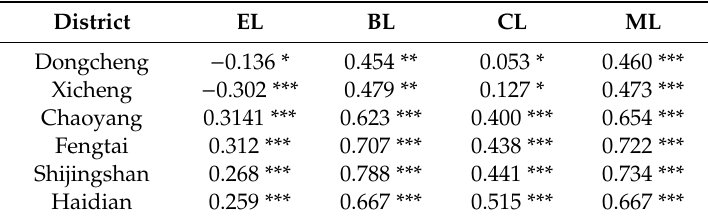
Table 5. The correlation coe ffi cients between the supply index (SI) and societal needs index (SNI). District EL BL CL ML Dongcheng − 0.136 * 0.454 ** 0.053 * 0.460 *** Xicheng − 0.302 *** 0.479 ** 0.127 * 0.473 ***